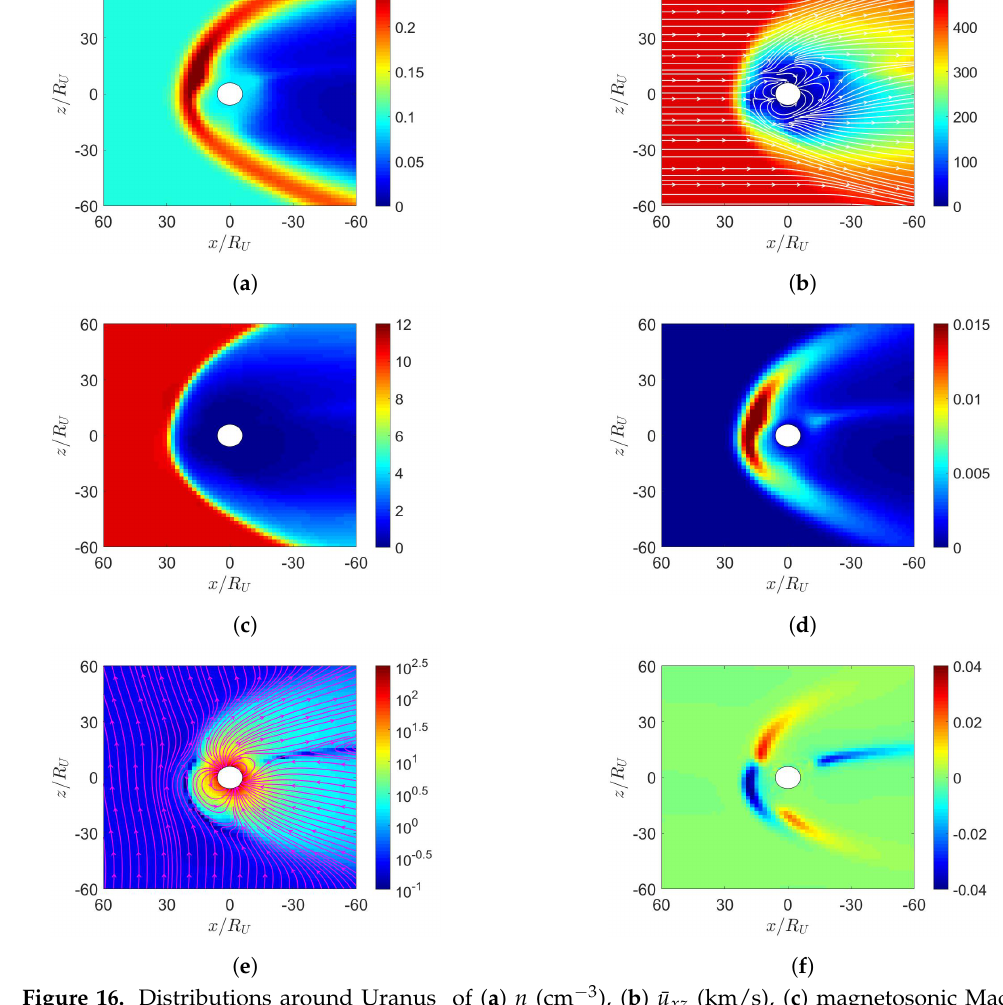
Figure 16. Distributions around Uranus of ( a ) n (cm − 3 ), ( b ) ¯ u xz (km/s), ( c ) magnetosonic Mach number, ( d ) P (nPa), ( e ) ¯ B xz (nT), ( f ) J y (nA/m 2 ); initial dipole tilts up and towards the sun, northward IMF, t = 85.4